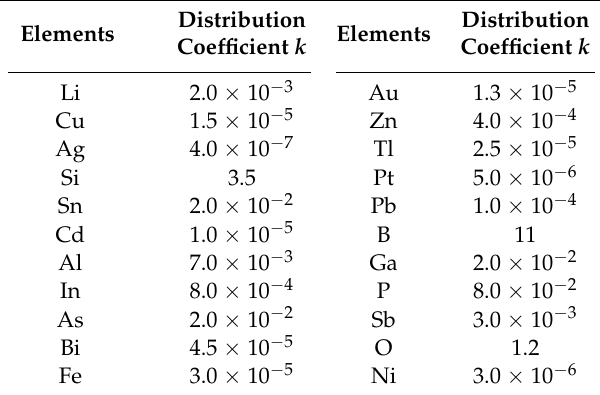
Table 1. Distribution coefficients of impurities in